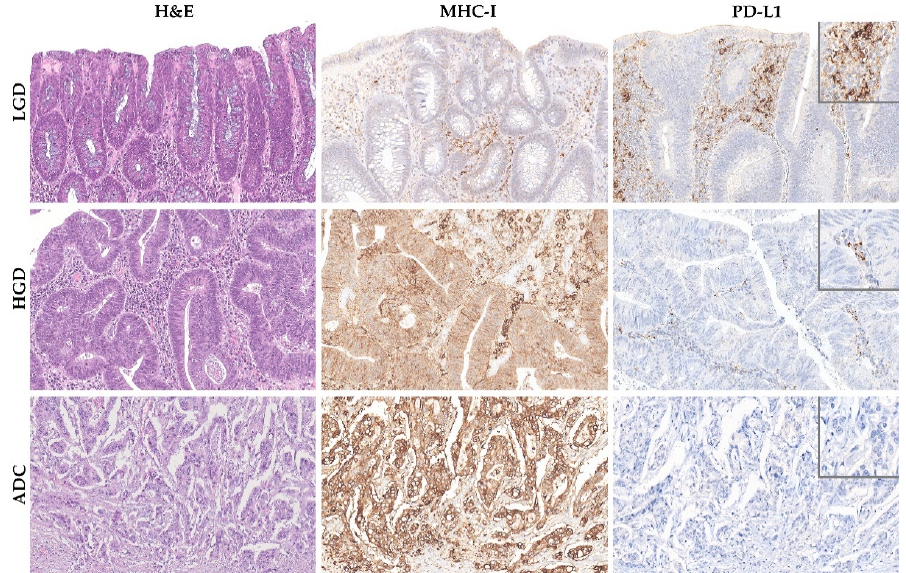
Figure 6. MHC-I and PD-L1 expression along the colorectal adenoma-carcinoma squence in representative examples of sporadic adenomatous lesion with low-grade dysplasia (LGD) ( upper panel), sporadic adenomatous lesion with high- grade dysplasia (HGD) ( middle panel), and sporadic invasive adenocarcinoma (ADC) ( lower panel). Note the membra- nous and cytoplasmic immunoreactivity of MHC-I in neoplastic cells of HGD and invasive ADC lesions. Hematoxylin and eosin ( left panel) and immunohistochemistry for MHC-I ( middle panel) and PD-L1 ( right panel), 40x amplification. The insets in the right panel represent higher magnification of PD-L1 immunohistochemistry, 400x amplification. 2.3. PD-L1 Expression Decreases throughout the Colorectal Adenoma Carcinoma Sequence.